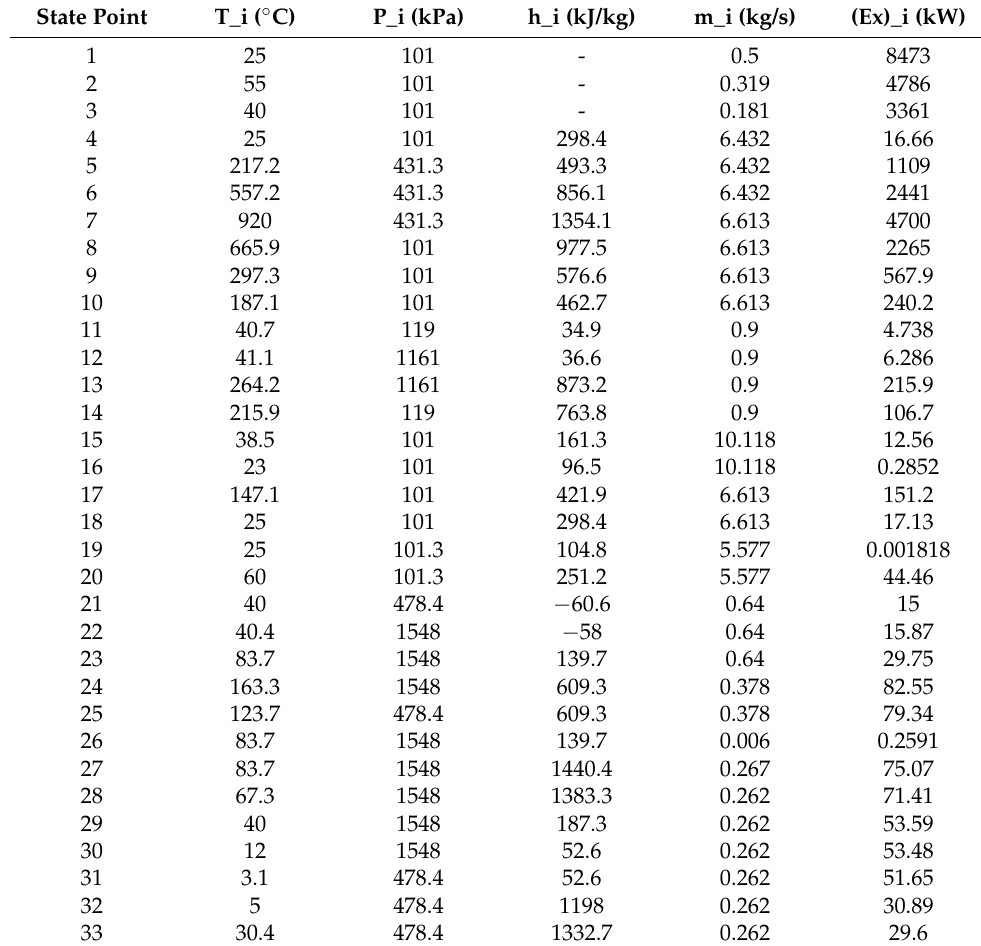
Table 4. State point properties of the multigeneration system.